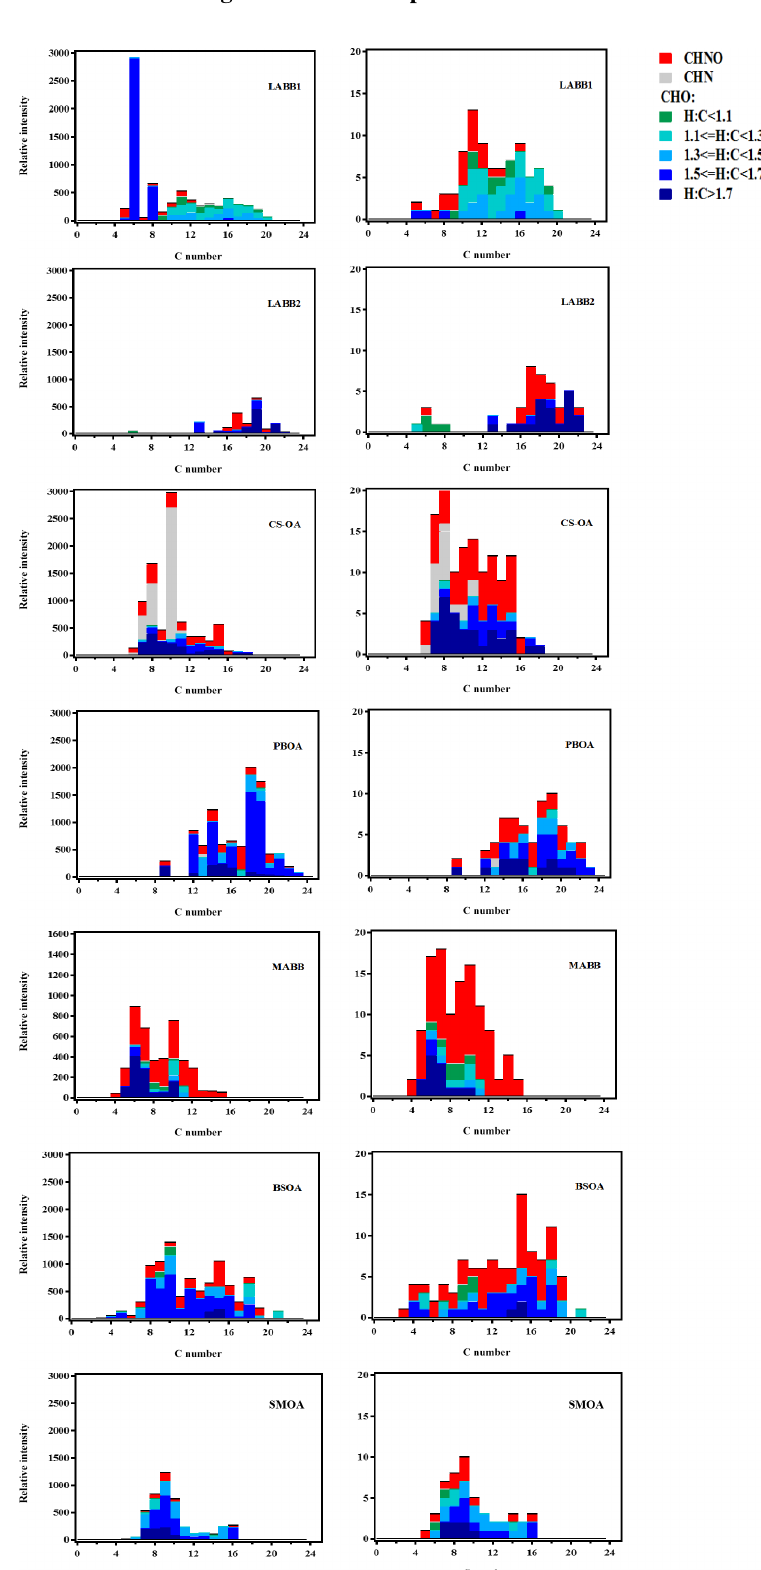
Figure 5. Stacked histogram binned by carbon number and colored by chemical family of key ions derived from clustergram analysis of factor mass spectra. Two representations are shown, with the stacked height denoting ion intensity (left column) or number of identified ions (right